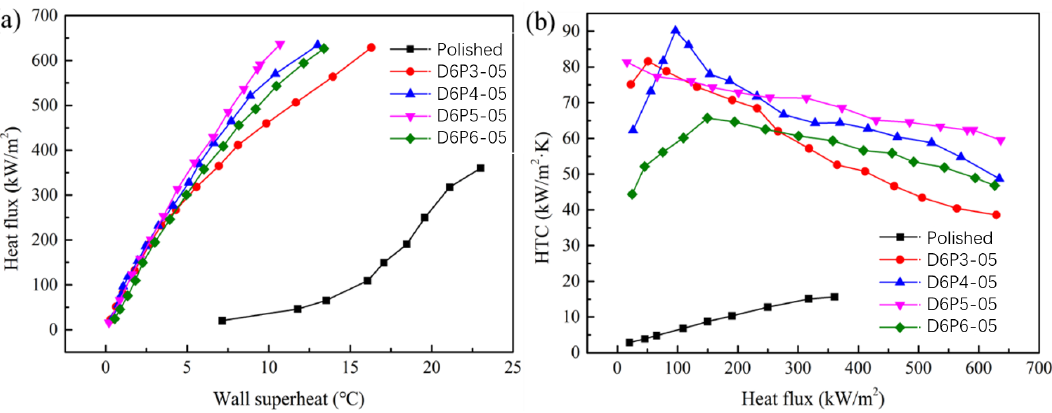
Figure 9. Sintered porous wick with different porosities (particle diameter 60 μm): ( a ) boiling curve, ( b ) boiling heat transfer coefficient.